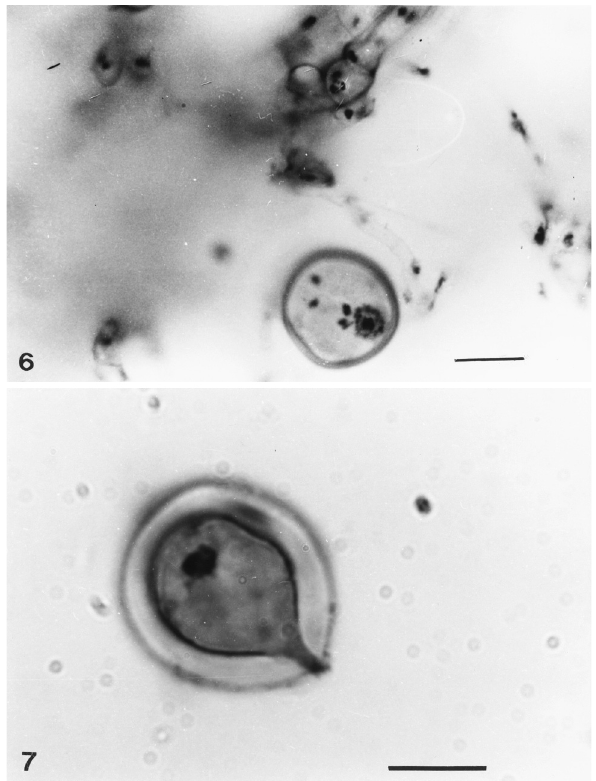
nuclei. Bar = 10 µ m. Figure 7. A single nucleus is observed several times larger than those of conidia and hyphae. Bar = 10 µ